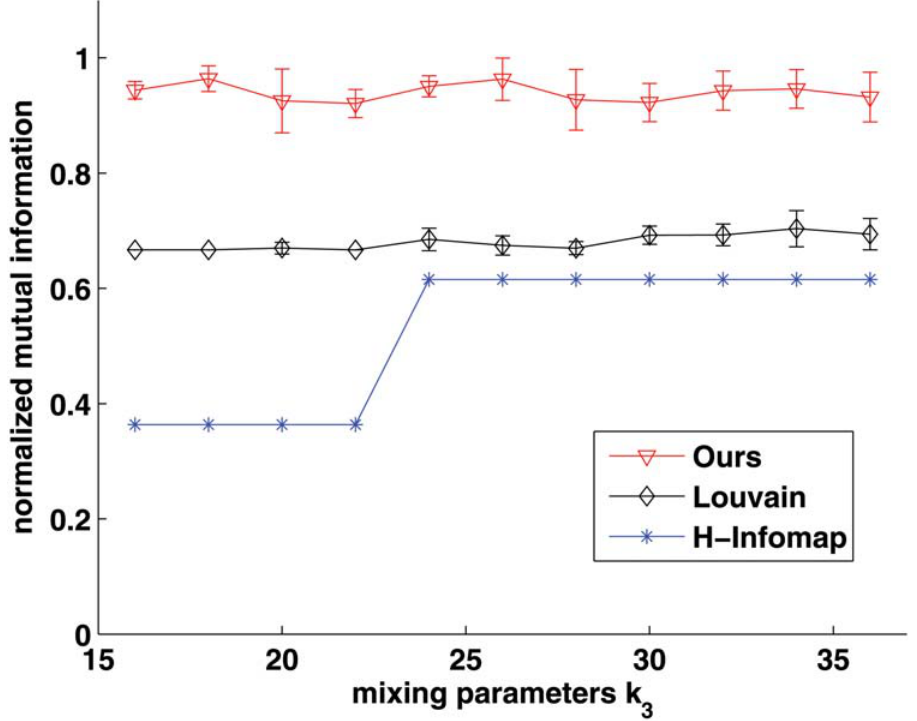
Fig 6. Comparison with Louvain method and H-Infomap on hierarchical community benchmarks at its second level. X-axis indicates the mixing parameter, and the Y-axis indicates the normalized mutual information.